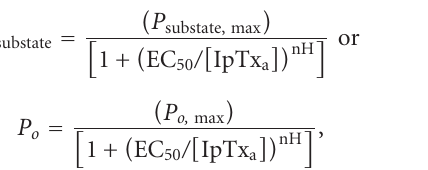
Supplementary Figure 1 (in Supplementary material avail- able online at doi: